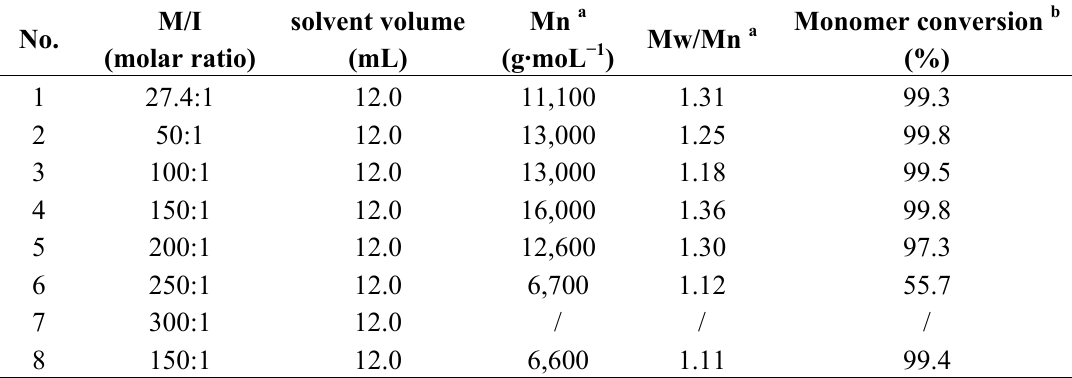
Table 1. Polymerization of Lac-OCA Initiated by Nd(O i Pr)